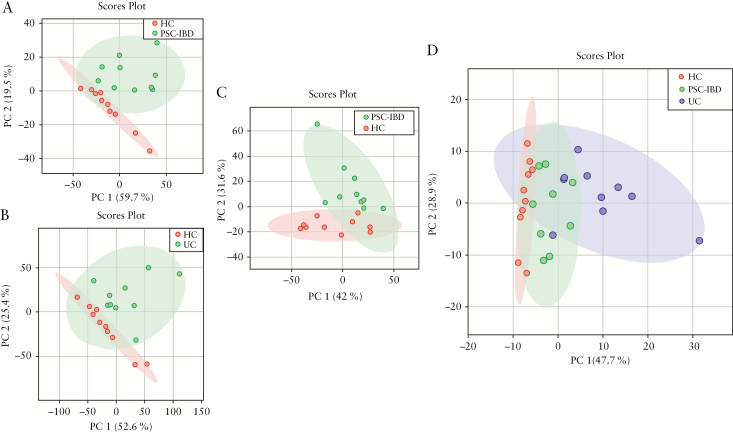
Principal component analysis [PCA] score plot performed on the mucosal transcriptome datasets demonstrating clustering of subjects within, and variation between, cohorts. Dots represents samples and are coloured according to the subject cohort. Ellipse represents 95% confidence. Results are plotted according to the PC1 and PC2 scores, with the percent variation explained by the respective axis. [a] PSC-IBD versus HC; [b] UC versus HC; [c] PSC-UC versus UC; [d] PCA plots demonstrating variation between HC, UC, and PSC-UC samples. The three groups were significantly different from each other [p = 0.01]. PSC, primary sclerosing cholangitis; IBD, inflammatory bowel disease; UC, ulcerative colitis; HC, healthy controls.